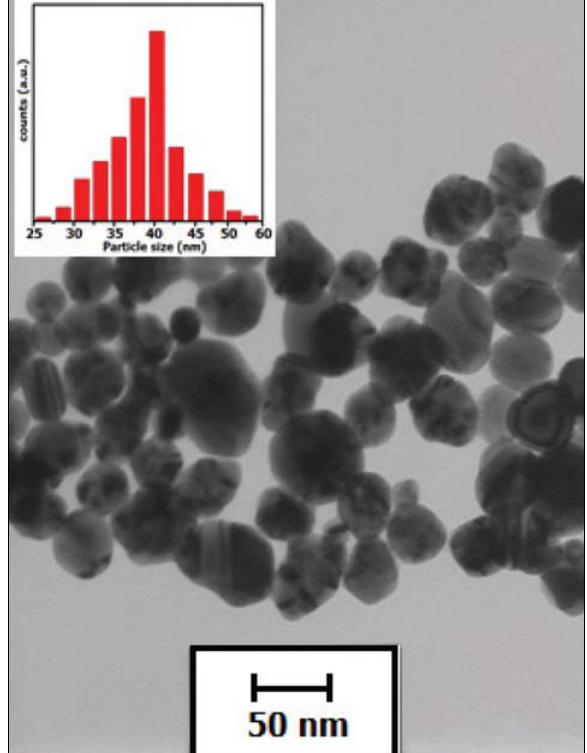
Figure 6. TEM image of the Ag NPs. The inset shows the size di- stribution of the Ag NPs.